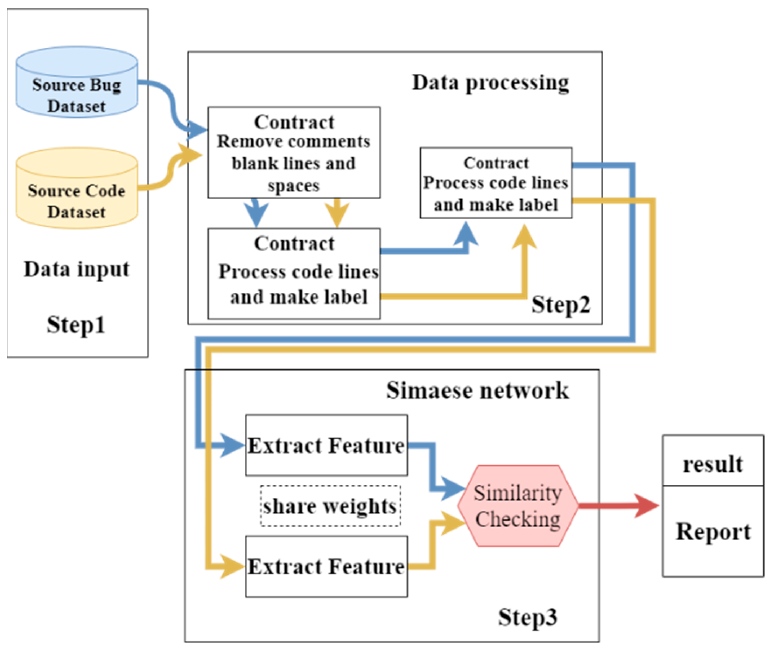
Figure 4. SCVSN model structure.